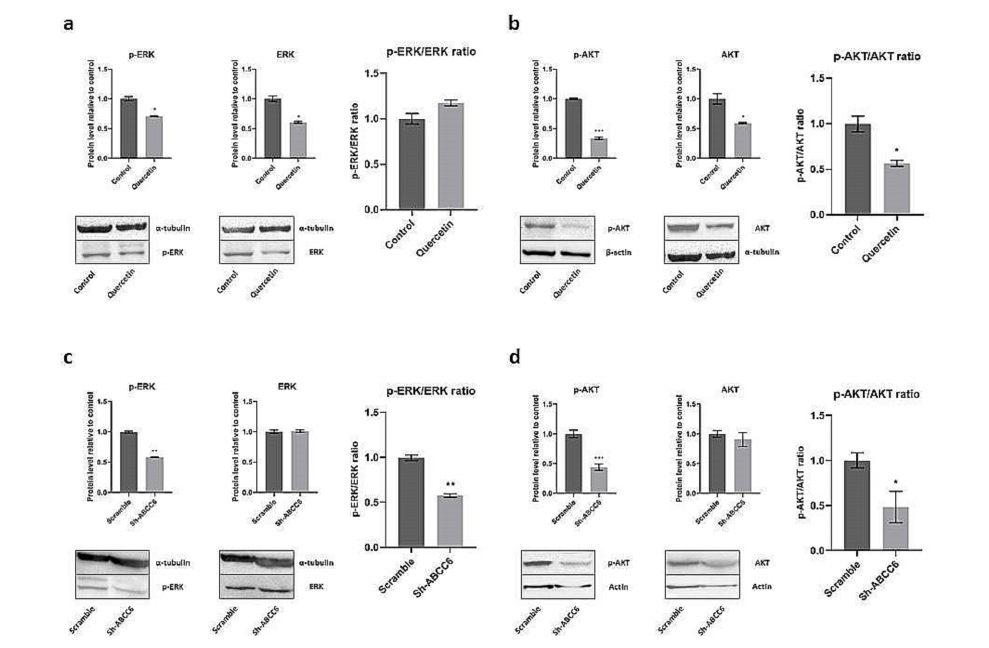
Figure 6. Effect of Quercetin treatment ( a , b ) or ABCC6 silencing ( c , d ) on phosphorylated AKT and ERK. The ratios between phosphorylated and total ERK ( a , c ) and between phosphorylated and total AKT ( b , d ) were determined by comparing the intensities of the immunoreactive bands obtained by using specific antibodies. Cells treated with DMSO 0.25% or scrambled sh-RNA were used as controls for HepG2 cells treated with Quercetin and subjected to ABCC6 knockdown, respectively. α -tubulin or β -actin were used as a loading control. Data are presented as the mean and the standard error of the mean of three independent experiments. Results were analyzed by Student’s t test; * p < 0.05; ** p < 0.01; *** p <